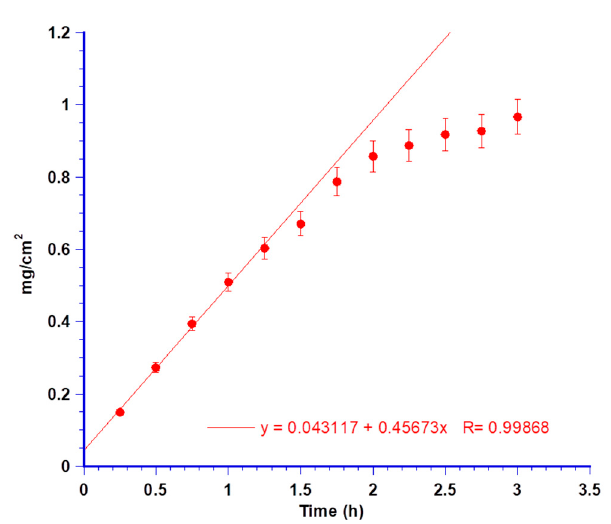
Figure 10. Permeation data of MTR per cm2 throughout the leukocyte and platelet-rich fibrin (L-PRF) membrane and linear fitting at the steady-state concentrations. Values are presented as means ± SE ( n = 6).